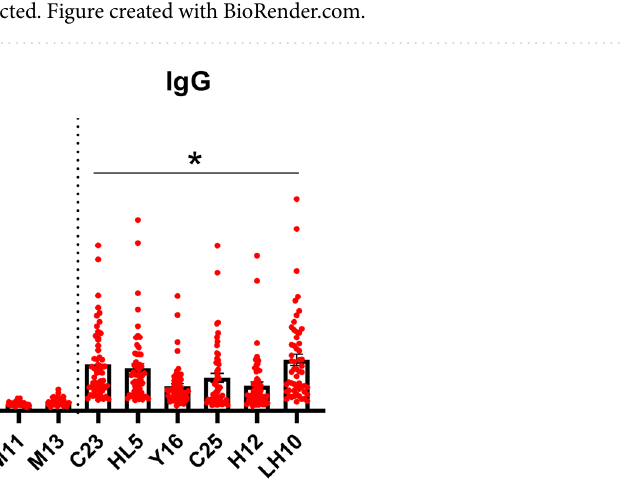
Figure 3. Clones specific for IgG showed higher reactivity with sera from dogs infected with D. repens than IgM-specific clones. To perform phage ELISA plates were coated with 1.46 × 10 11 pfu/well of selected clones in TBS. The blocking step was performed with 0.1 M NaHCO 3 , 0.5% BSA and washed three times. Dogs sera were used in 1:800 dilution in blocking buffer, and secondary anti-dog IgG/IgM-HRP antibodies were diluted 1:50,000 in blocking buffer. The statistically significant differences between examined groups are marked with an asterisk: * p <